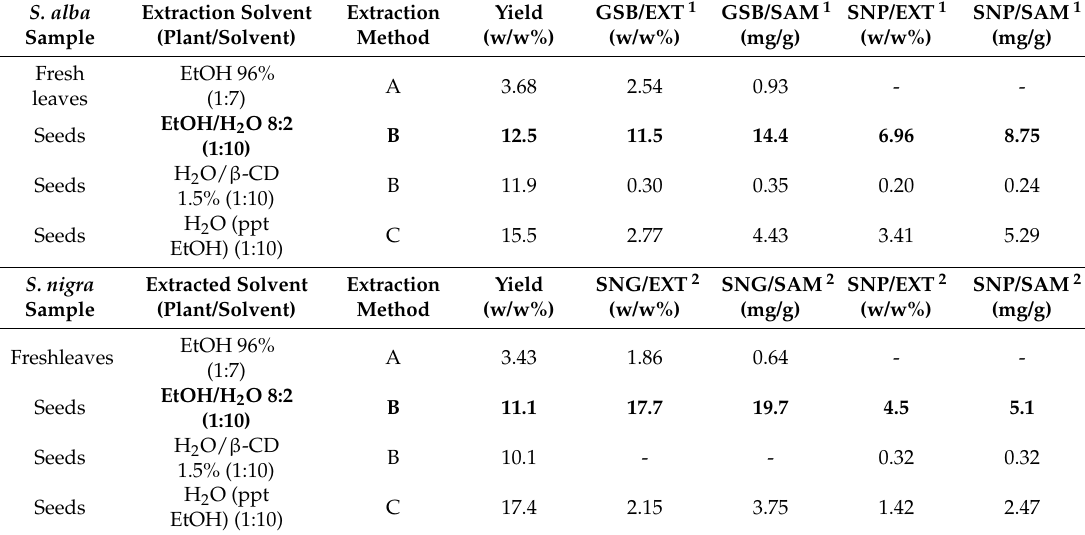
Table 1. Sinapis alba ( S. alba ) and Sinapis nigra ( S. nigra ) extraction conditions, extraction yields and sinalbin sulfonate (GSB), sinigrin (SNG) and sinapine (SNP) percentages in the obtained extracts (EXT) and in the vegetal matrices (SAM). The values highlighted in the table are referred to the high GSB and SNG